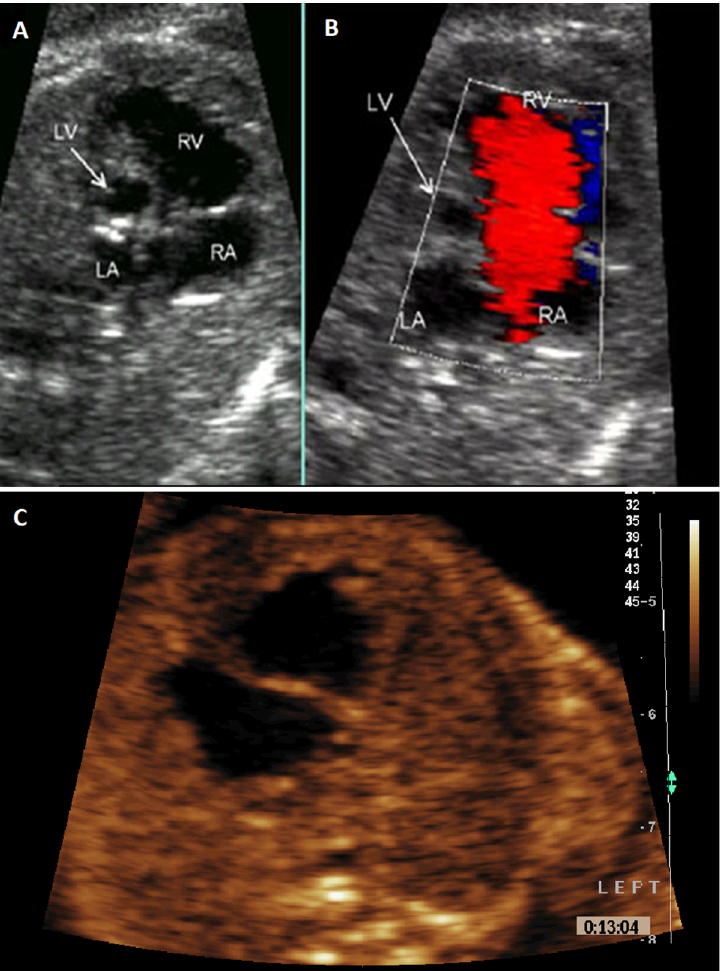
Figure 2. ( A ) Hypoplastic left heart syndrome fetal echocardiogram in a four-chamber view with noticeably reduced dimensions of the left ventricle compared to the right ventricle. ( B ) The same heart presented in color Doppler echocardiography. The embryogenesis of this heart is usually at 6–8th week after conception or even later on. ( C ) Single fetal echocardiogram. This heart in terms of embryology was earlier developed comparing with hypoplastic left heart syndrome, usually 4–5th week after conception. Legend: LA—left atrium, LV—left ventricle; RA—right atrium, RV—right ventricle.